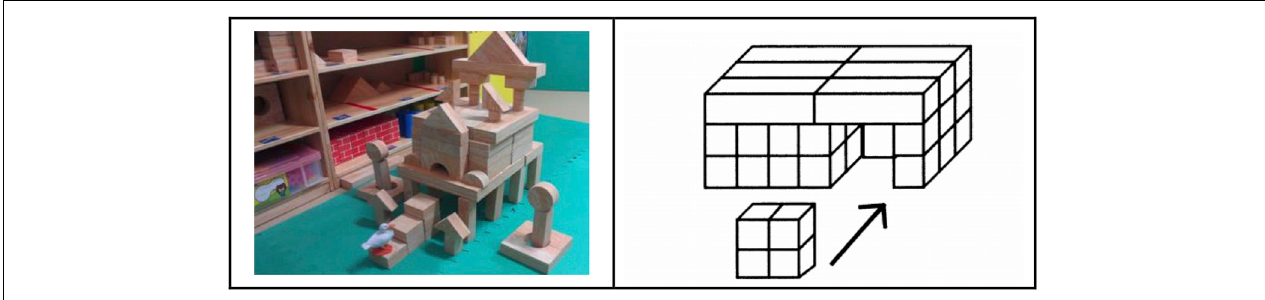
FIGURE 2 | An example of a finished product scored as 9 (on the left panel) and the defining characteristics of products scored as 9 (3-d horizontal closure structure with 2 block-high, roof and internal space) (on the right panel).